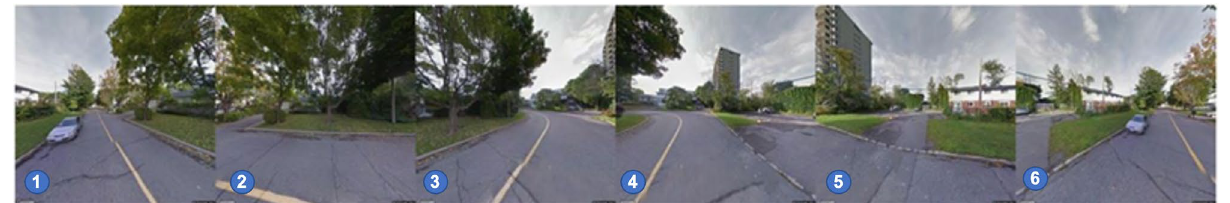
Figure 1. Example of six horizontal Google Street View images for a given postal code location*. *The image segmentation algorithm used all images (images 1 to 6) while the object detection algorithm used every second image (images 1, 3, and 5) to avoid counting the car twice. Images extracted from Google Street View: © 2002 distances of 250, 500, 750, 1000, 1250, 1500, 1750 and 2000 m from the original observation. The distributions of Sky IS and Vegetation IS metrics were normally distributed. All other GSV image-derived metrics showed a